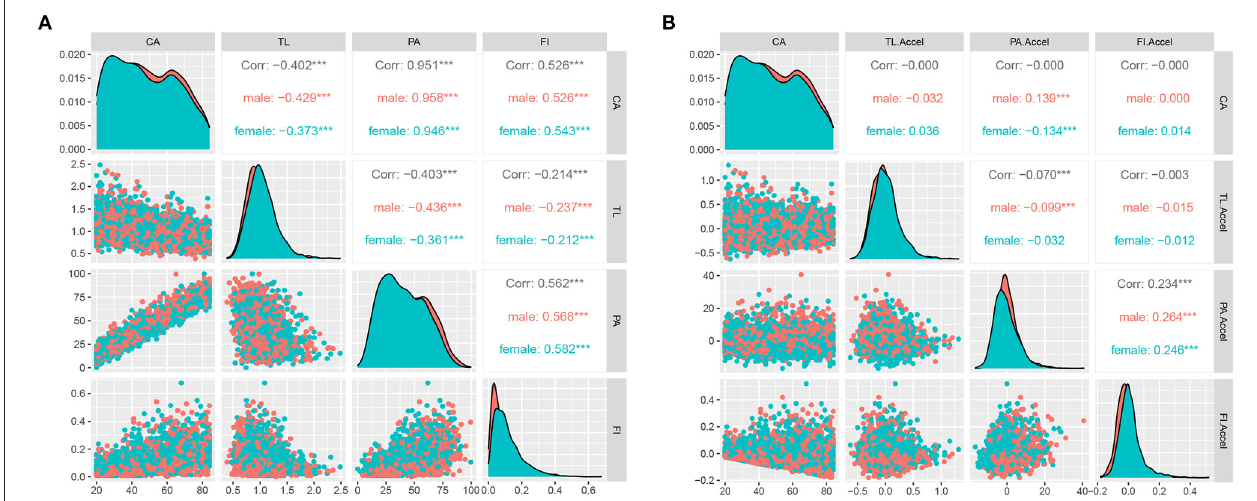
FIGURE 1 | Correlations between three aging measures and chronological age. CA, chronological age; TL, telomere length; PA, Phenotypic age; FI, frailty index; TL.Accel, PA.Accel and FI.Accel represent residuals from linear models when regressing TL, PA, and FI on CA, respectively. *** p < 0.001. (A,B) represent correlations before and after adjustments of chronological age,